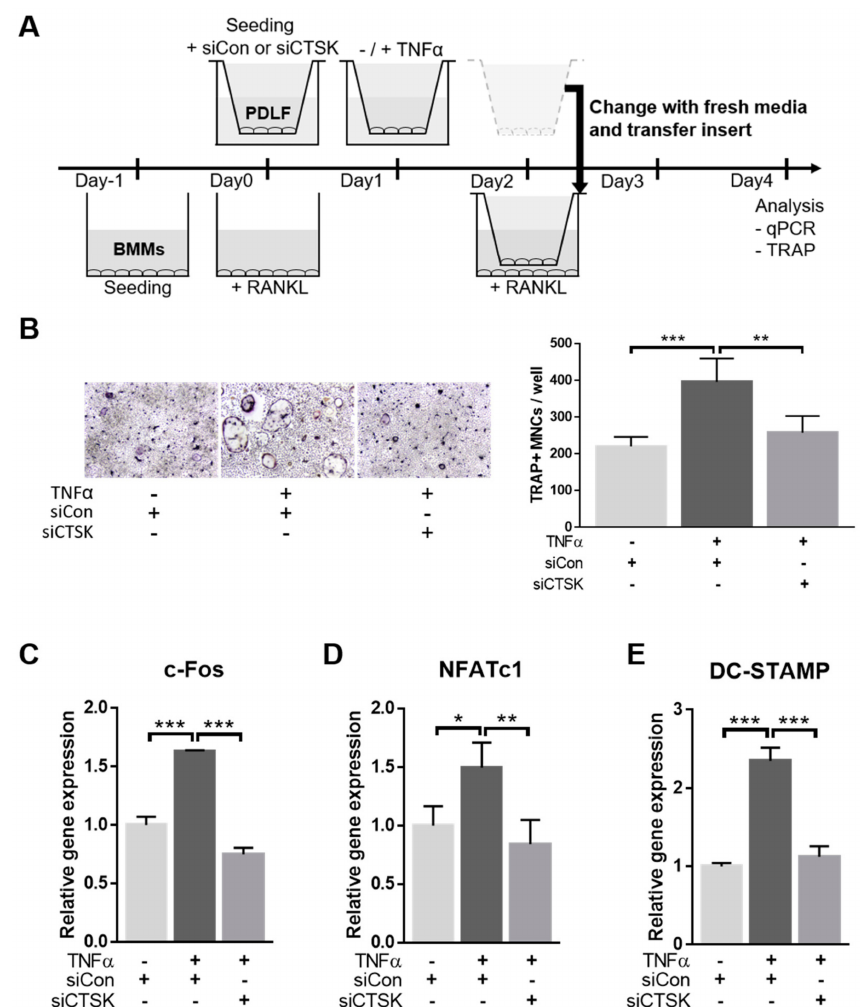
Figure 5. The involvement of CTSK on TNF α -induced stimulatory effect of PDLFs in osteoclastogenesis. ( A ) A schematic diagram of the experimental procedure. PDLFs transfected with either siControl or siCTSK were seeded on the upper chamber of the transwell. After 24-h treatment with TNF α , the PDLF-seeded upper chamber was transferred onto the BMM-seeded lower chamber. Osteoclastogenesis was induced with 100 ng/mL of RANKL every other day for a 4-day period. ( B ) Representative images of TRAP staining (left) and quantitative analysis (right) of TRAP-positive MNCs. ( C – E ) The mRNA expression of osteoclastogenic markers, including c-FOS, NFATc1, and DC-STAMP in BMMs, was determined by qPCR and normalized to β -actin expression. Data represent the mean ± S.E.M. * p < 0.05, ** p < 0.01, and *** p < 0.001 by one-way